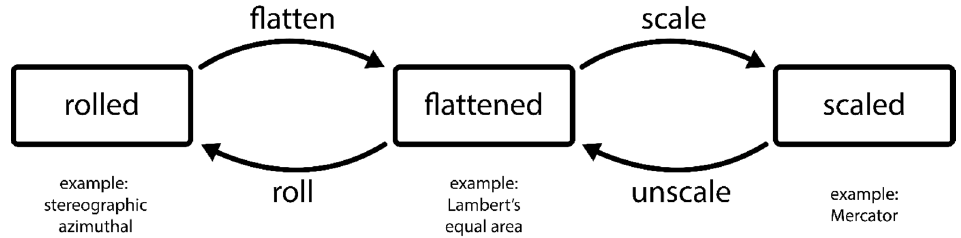
Figure 3. Major states of the interactive visualization process to construct different map projections. Arrows indicate transitions between the states, which are generally realized as smooth animations.